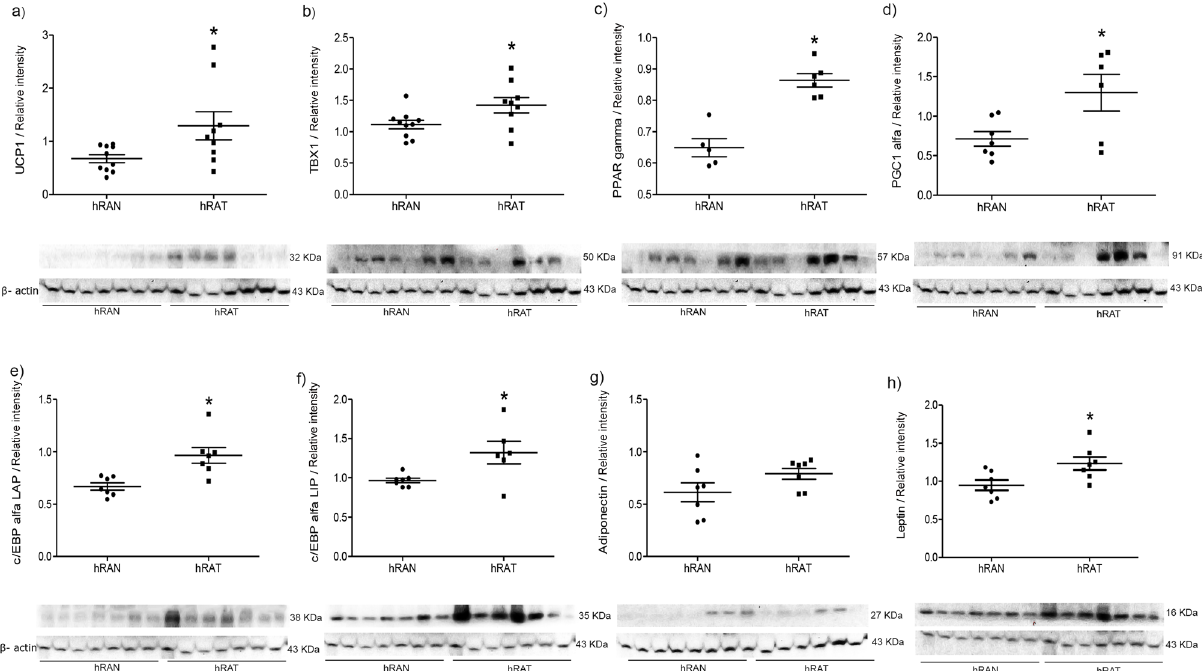
Figure 4. UCP1, TBX1, PPAR gamma, PCG1 alpha, c/EBPα LAP, c/EBPα LIP, adiponectin and leptin in tissue lysate of hRAN and hRAT . UCP1, TBX1, PPAR gamma, PCG1 alpha, c/EBPα LAP, c/EBPα LIP, adiponectin and leptin expression were evaluated by Western blot. Images were analyzed by densitometry. Horizontal bars represent the geometric mean of each data set. Vertical bars indicate SEM. * p < 0.05 hRAN versus